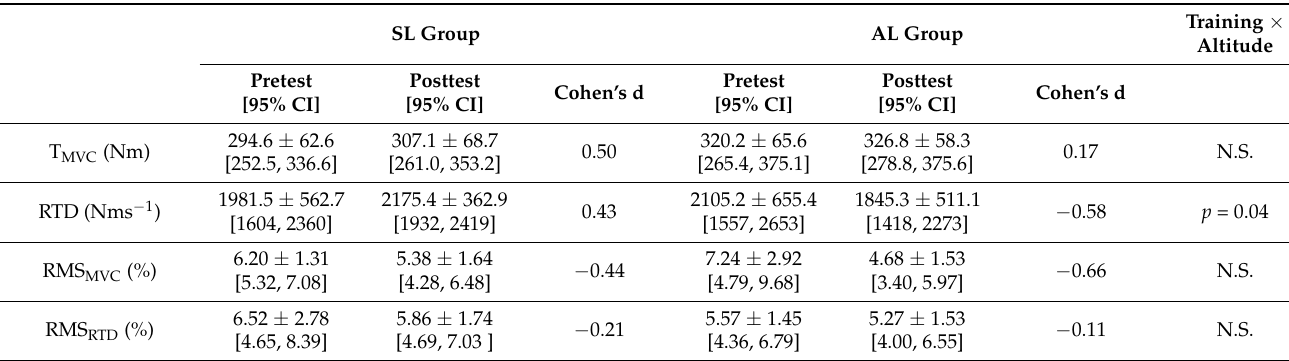
Table 4. Isometric knee strength with muscle activity before and after explosive and endurance strength training in elite judo athletes. SL Group AL